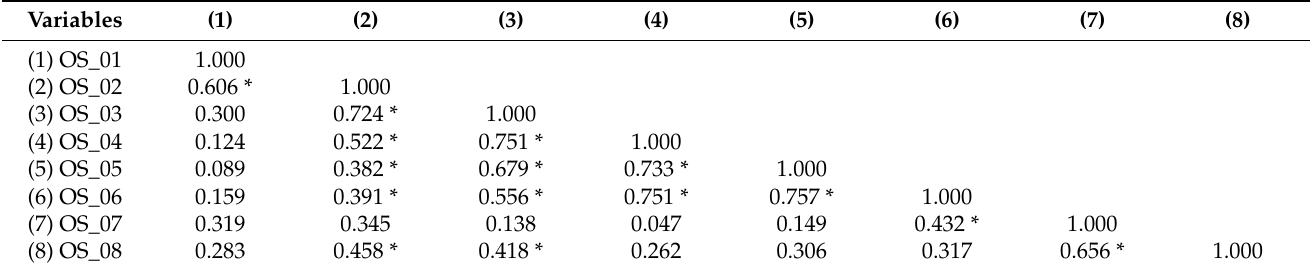
Table 8. Pearson correlations between overall satisfaction’s